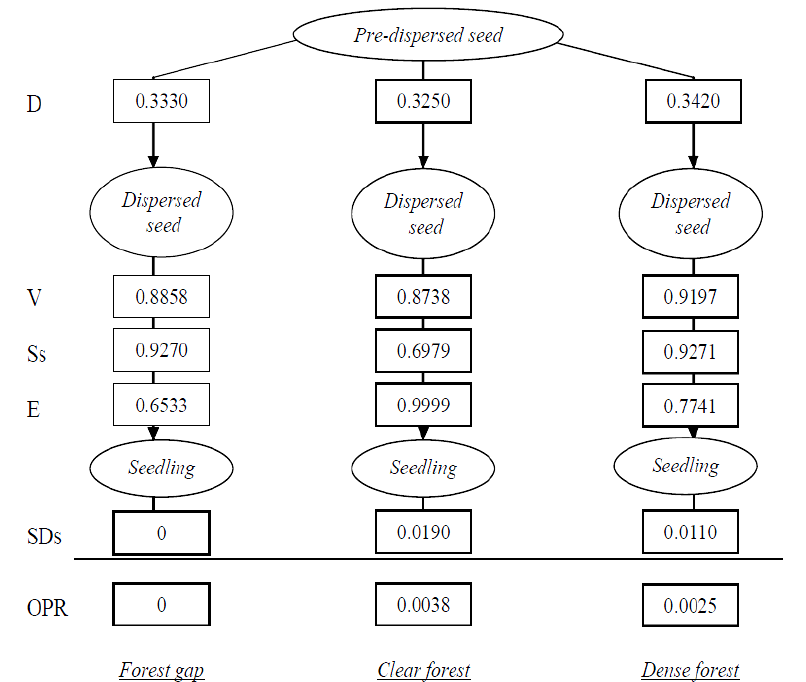
Figure 3. Diagram of the spatial dynamics of recruitment in each one of the microhabitats considered. Ovals represent the stages and rectangles the processes of recruitment analyzed. Values shown are process-specific transition probabilities (TPs). OPR represents the overall probability of recruitment at each microhabitat. D = seed dispersal; V = seed viability;